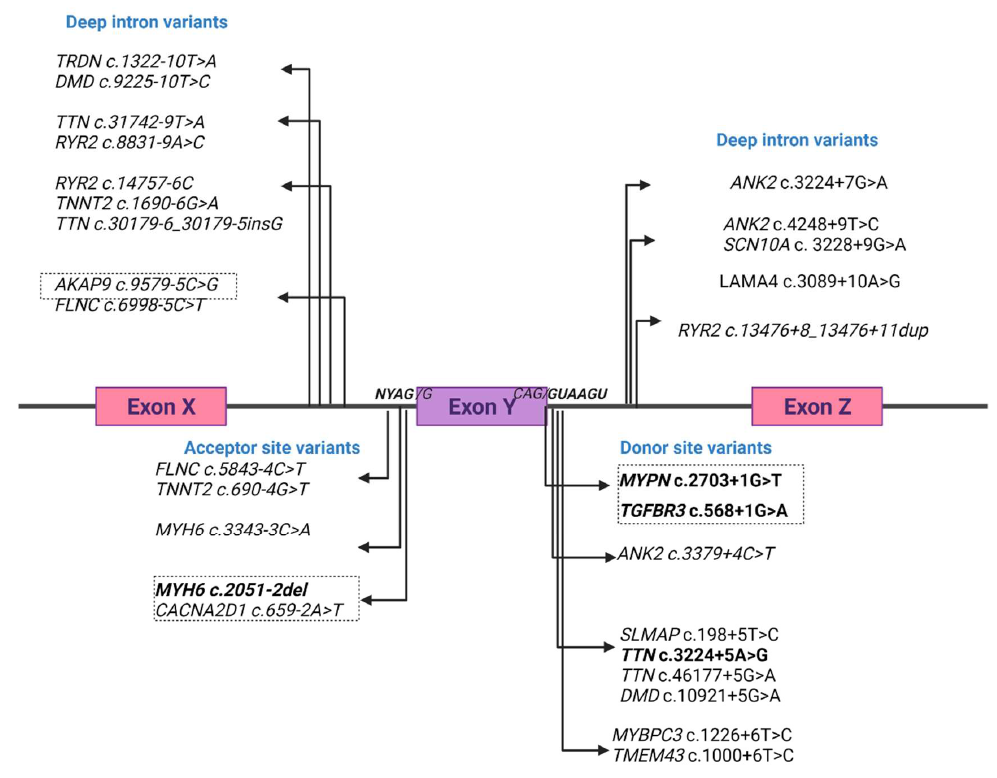
Figure 1. Schematic representation of selected intronic variants. Bold type indicates aberrant splicing shown experimentally. Dotted line indicates in silico predicted strong abnormal splicing. Table 2. In silico prediction and experimental effect of variants. Allele frequency obtained from the gnomAD database (allele count/allele number of European population). NA = not available.